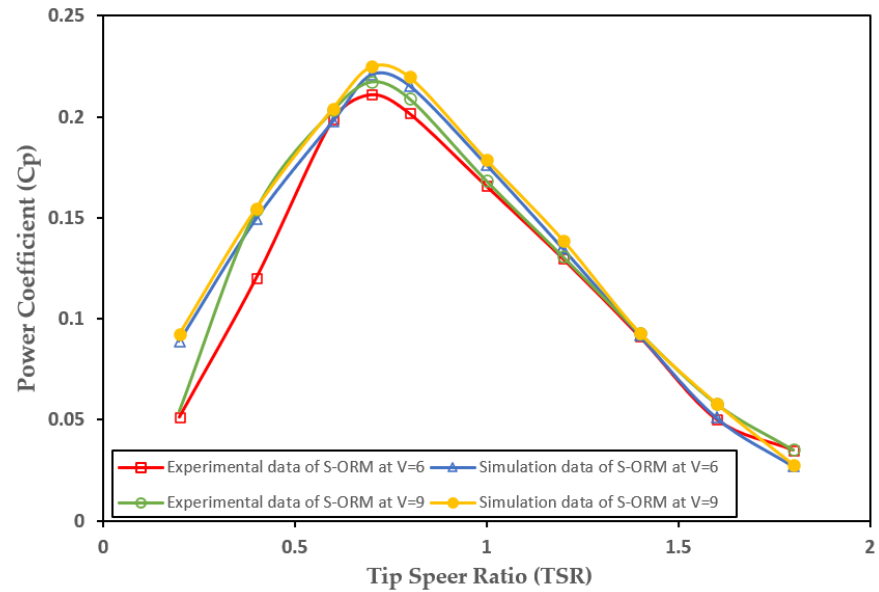
Figure 11. The variations in Cp with TSRs from 0.2 to 1.8.